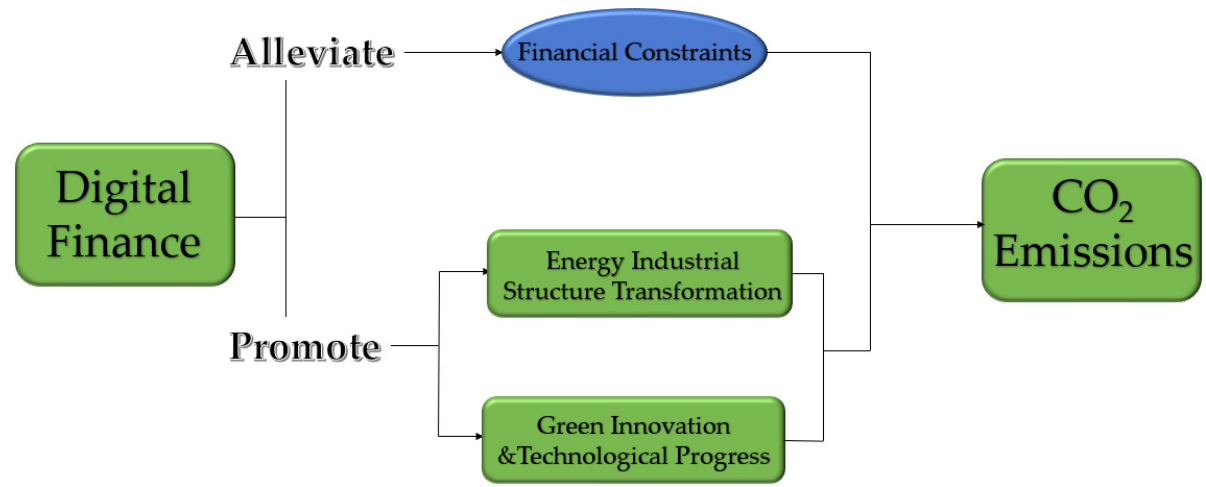
Figure 1. Graph of mechanisms of digital finance affecting CO 2 emissions.